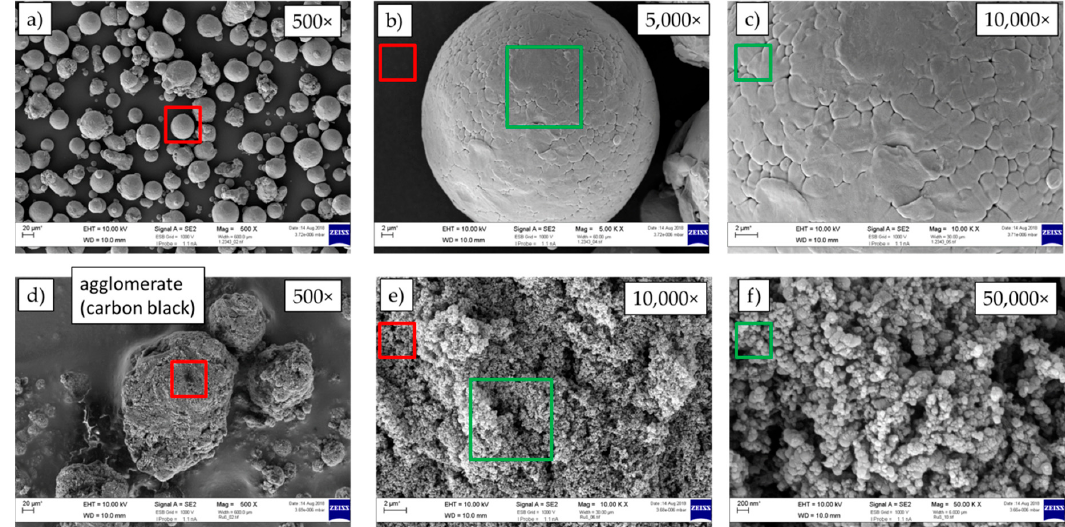
Figure 2. SEM images of the ( a – c ) unsieved AISI H11 powder (magnifications: 500×, 5000×, and 10,000×, respectively) and ( d – f ) of the carbon black nanoparticles (magnifications: 500×, 10,000× and 50,000×, respectively).